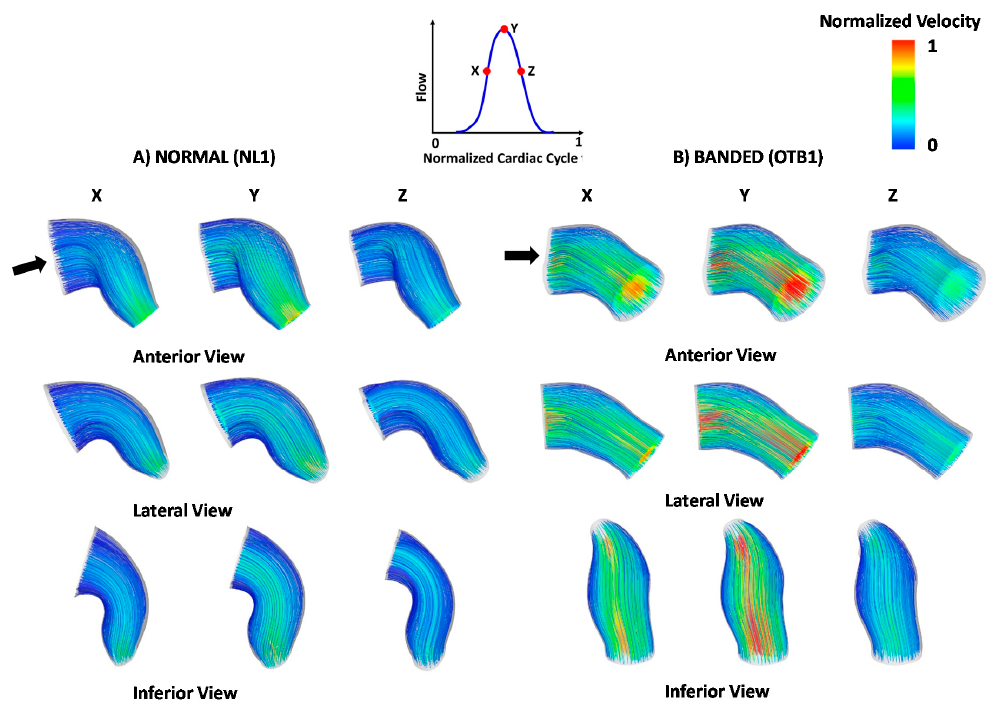
Figure 6. OFT blood flow velocities obtained from CFD simulations. 3D OFT configurations and flow patterns are shown at three times over the cardiac cycle for a representative ( A ) normal and ( B ) banded embryos. Black arrows indicate direction of blood flow. For each embryo, multiple views (anterior, lateral and inferior) of the OFT are shown. The streamlines depict the flow pattern in the OFT, and are colored by velocity magnitude, normalized to the normal embryo maximum velocity, which occurs close to the centerline of the OFT outlet region.